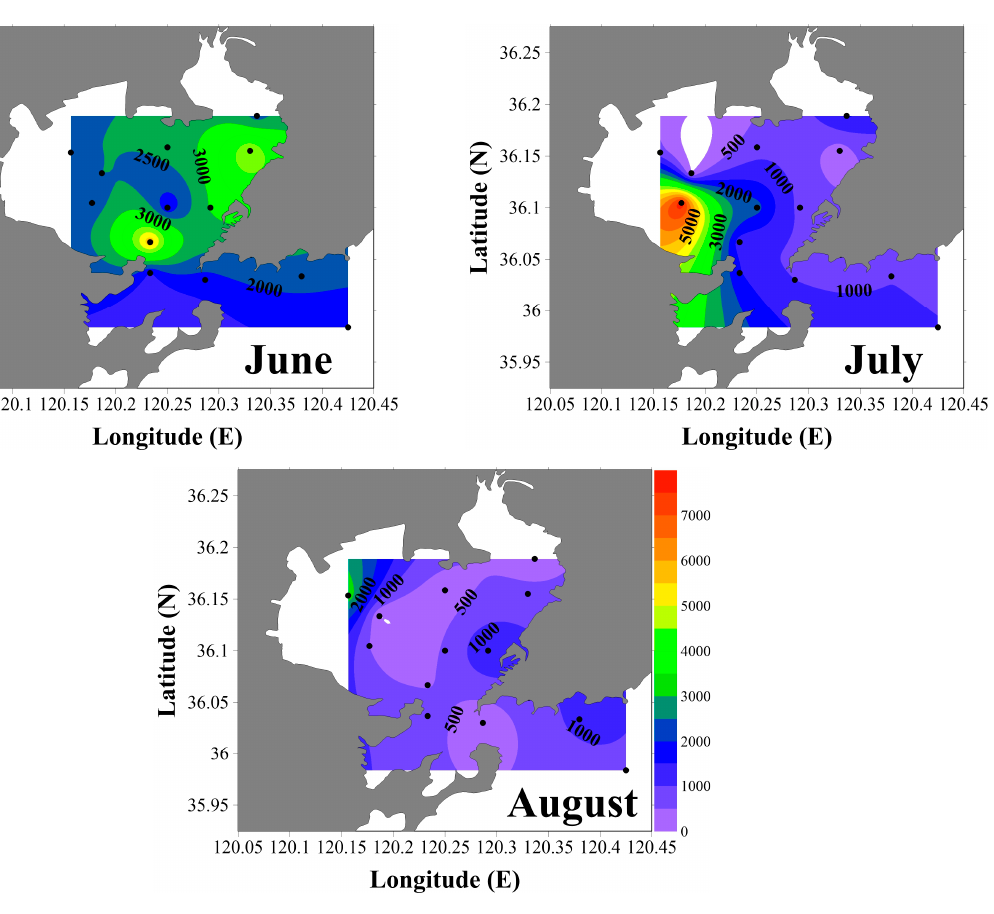
Figure 2. Horizontal distribution of Acartia bifilosa abundance (ind/m 3 ) in the Jiaozhou Bay from June to August.